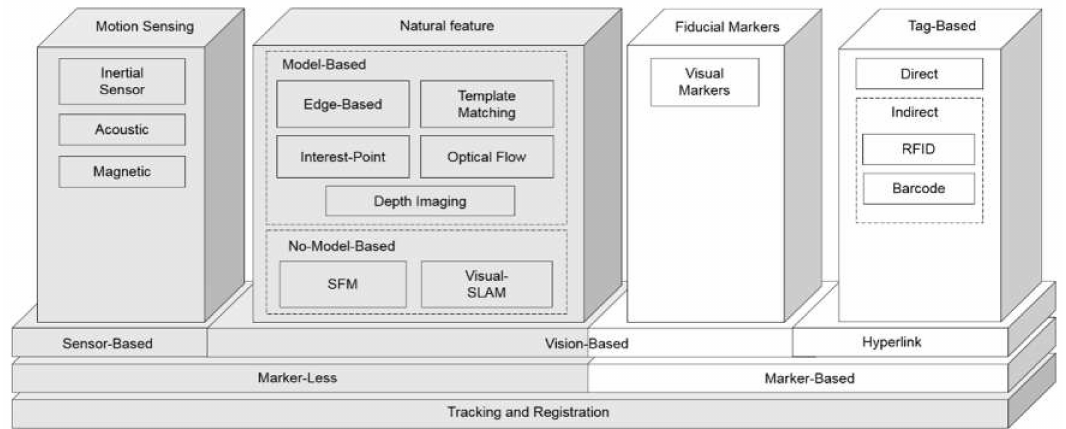
Figure 2. Tracking and registration techniques for mobile augmented